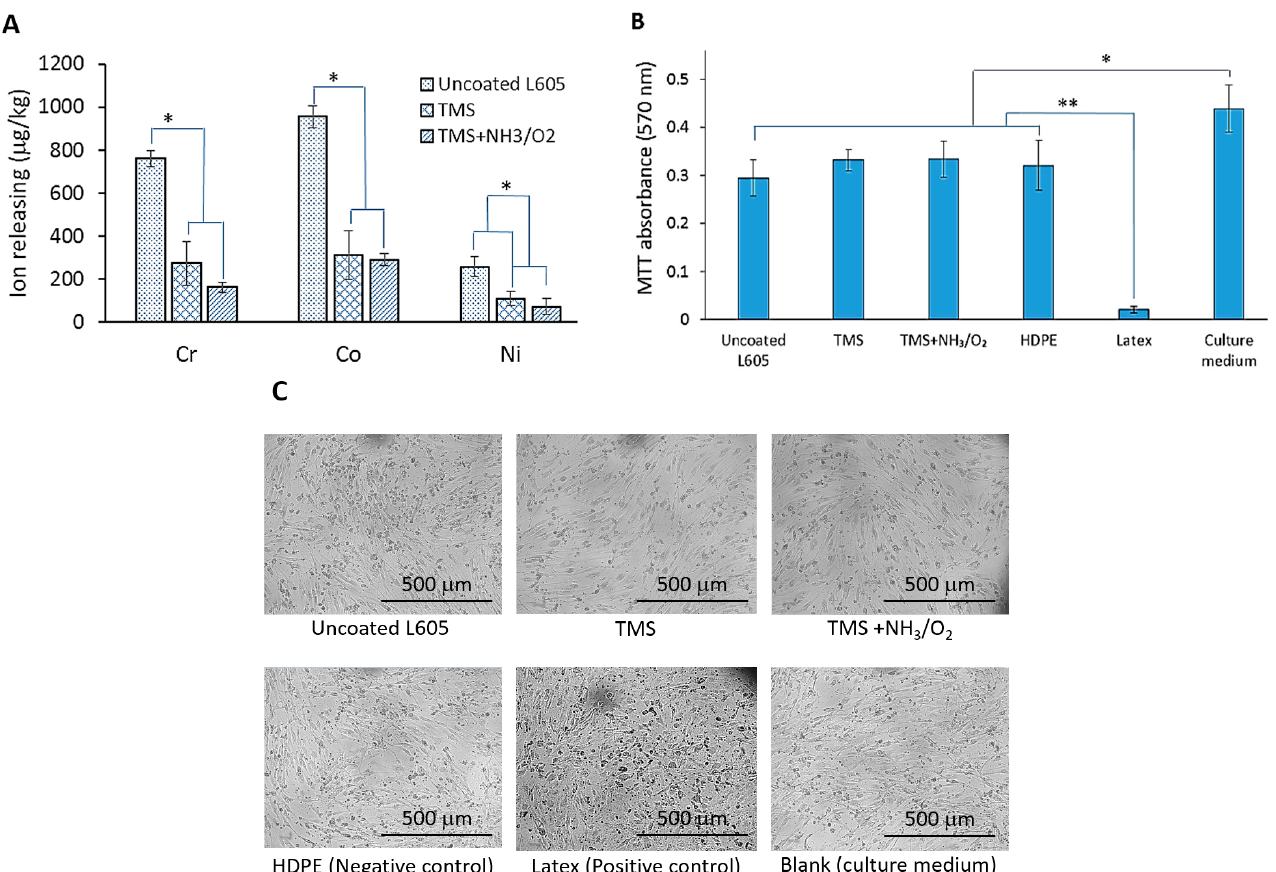
Figure 5. ( A ) Metal ion releasing amount detected from extracts of uncoated, TMS, and TMS+NH 3 /O 2 plasma-nanocoated L605 coupons. Plotted values are means ± SD ( n = 3); * p < 0.05. ( B ) PCAECs proliferation in cytotoxicity test evaluated by MTT assay. Plotted values are means ± SD ( n = 6); * p < 0.05 and ** p < 0.005. ( C ) Optical images (10 × ) for PCAEC morphology in cytotoxicity test after